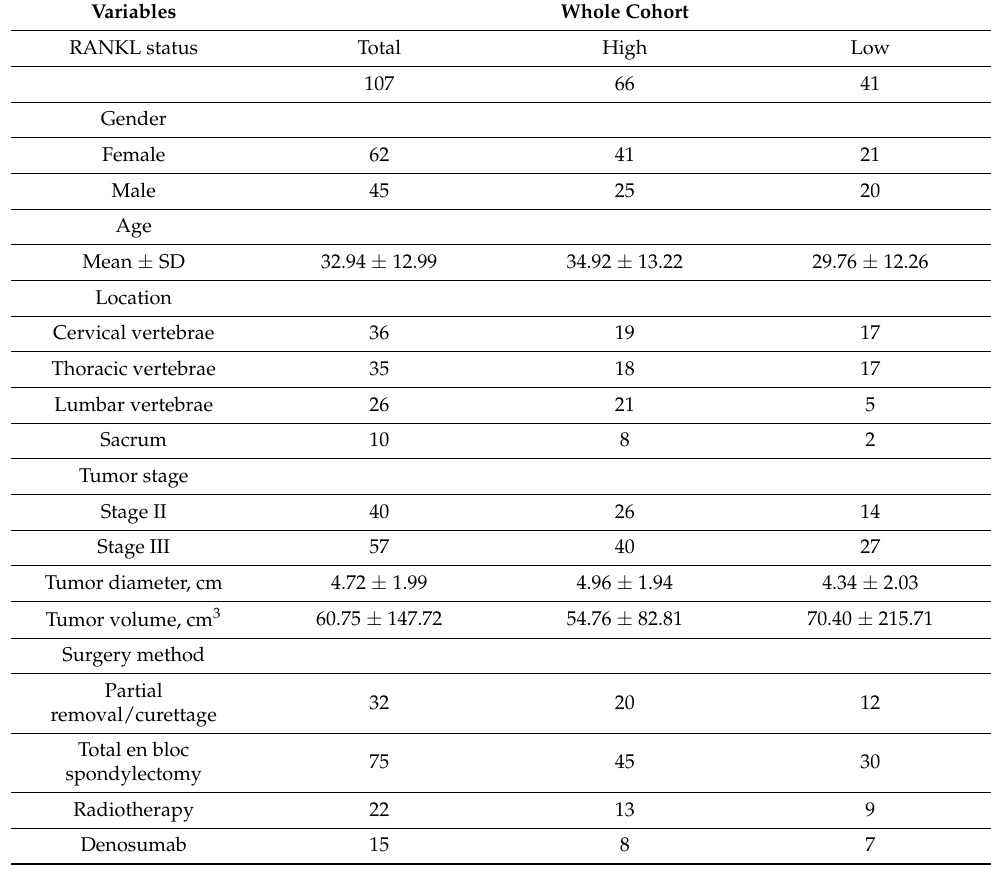
Table 1. Demographic and clinical information for the study